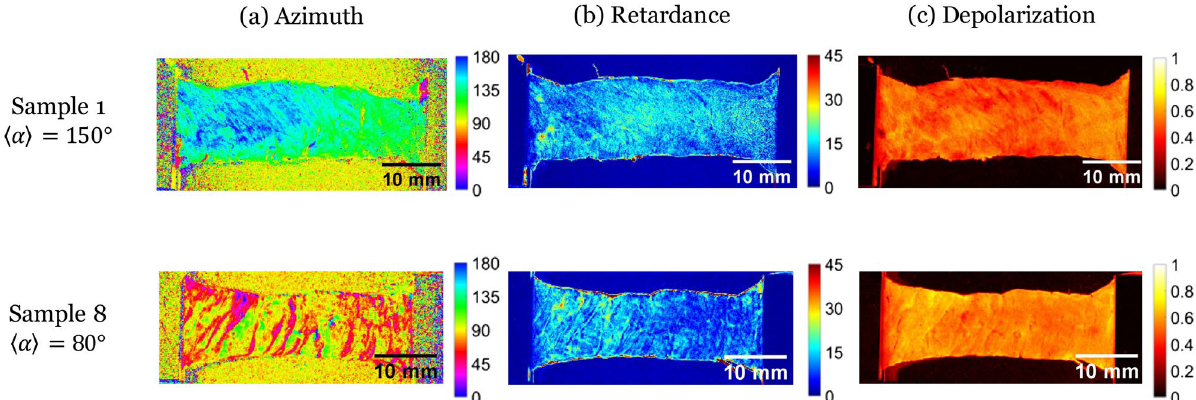
Figure 1. Maps of the Mueller polarimetry parameters [( a ) Azimuth α (in ◦ ), ( b ) retardance R (in ◦ ), ( c ) depolarization (cid:31) ] for two of our 9 samples, chosen for their different initial mean azimuth < α > (top—Sample 1, � α � ≈ 150 ◦ ; bottom—sample 8, � α � ≈ 80 ◦ ; direction of traction 0 ◦